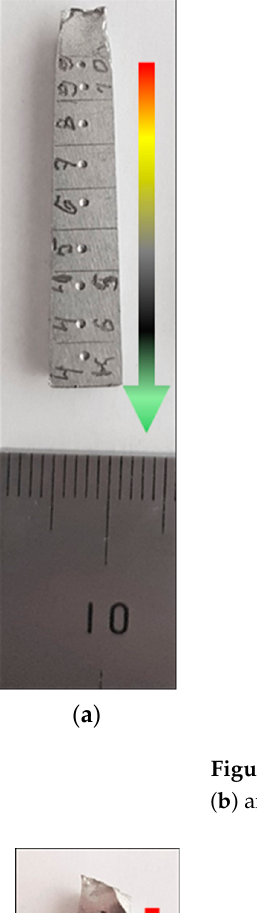
Figure 8. Hardness as the function of reference damage parameter for all applied loading regimes.